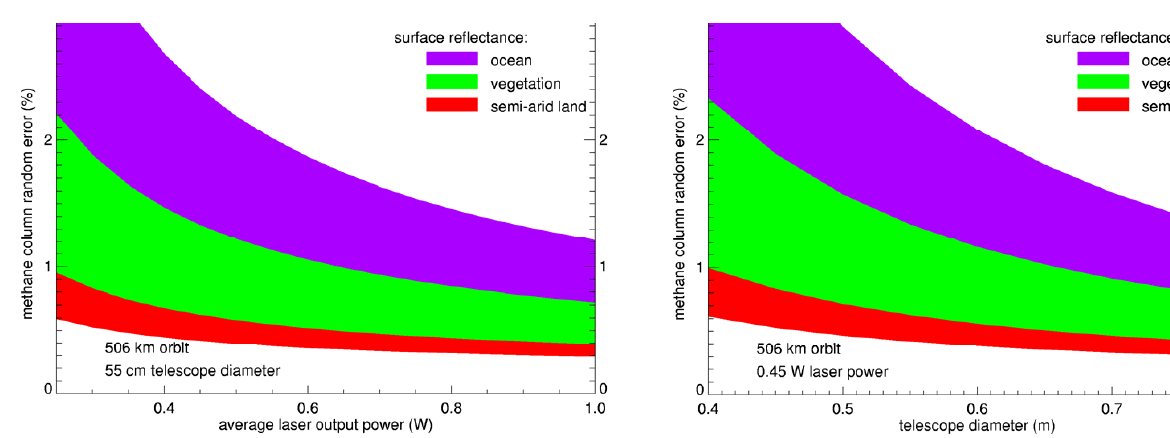
Fig. 7. Methane measurement precision δX CH 4 / X CH 4 as function of laser power and surface reflectance, assumed to range between 0.02–0.05sr − 1 for water (ocean), between 0.05–0.14sr − 1 for vege- tation, and 0.14–0.30sr − 1 for semi-arid land and desert. The MER- LIN baseline of Table 2 with 0.45W and 0.1sr − 1 yields a precision of 0.8%.